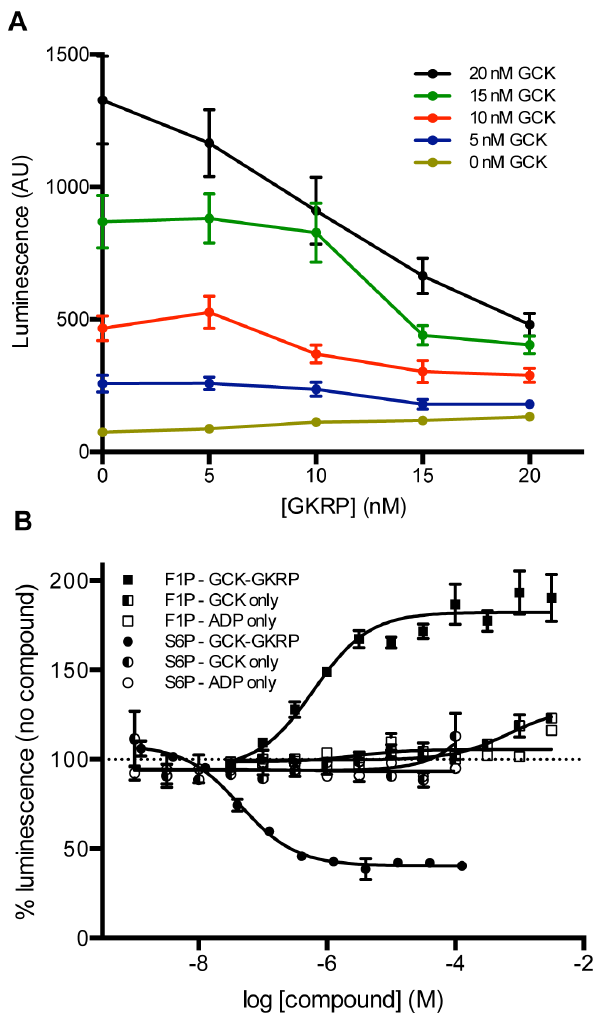
Figure 5. Optimization and validation of luminescence-based detection of the GCK enzymatic reaction. (A) The assay (pH 7.1) contained 5 mM glucose, 0.4 mM ATP, 2 m M S6P, and was terminated after 75 minutes. Each data point is mean 6 SEM for n=4. (B) Effect of GKRP modulators on the luminescence reaction. The reaction included 15 nM GCK and 15 nM GKRP (GCK-GKRP), 4 nM GCK (GCK only), or 0.04 mM ADP and no GCK or GKRP (ADP only). Assays were incubated for 75 minutes. Each data point is mean 6 SEM for